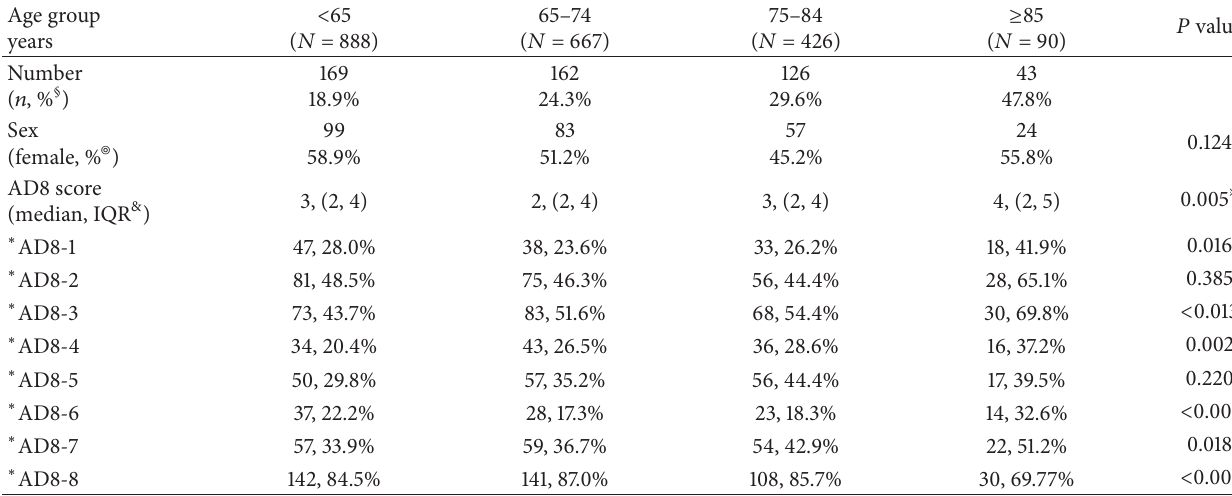
Table 3: AD8 subitems based on age groups among the suspected dementia #